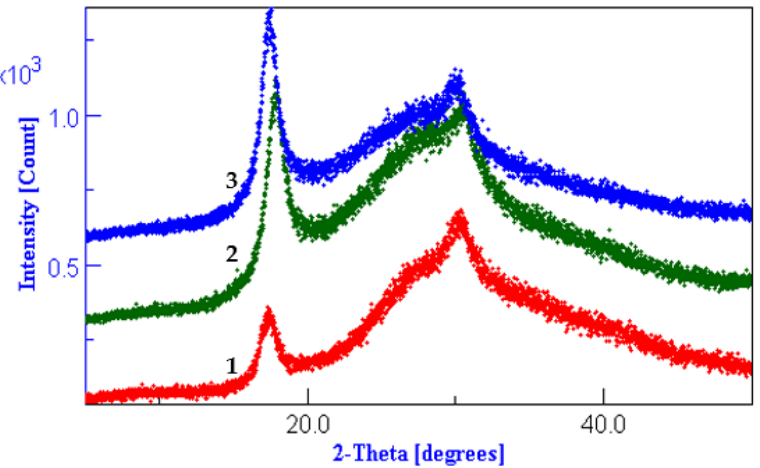
Figure 5. Diffractograms of Dralon L treated at 120 °C for 30 min with excess of reagents: ( 1 ) control sample, ( 2 ) sample V1 with KOH plus iodine, and ( 3 ) sample V2 with KOH plus iodine.